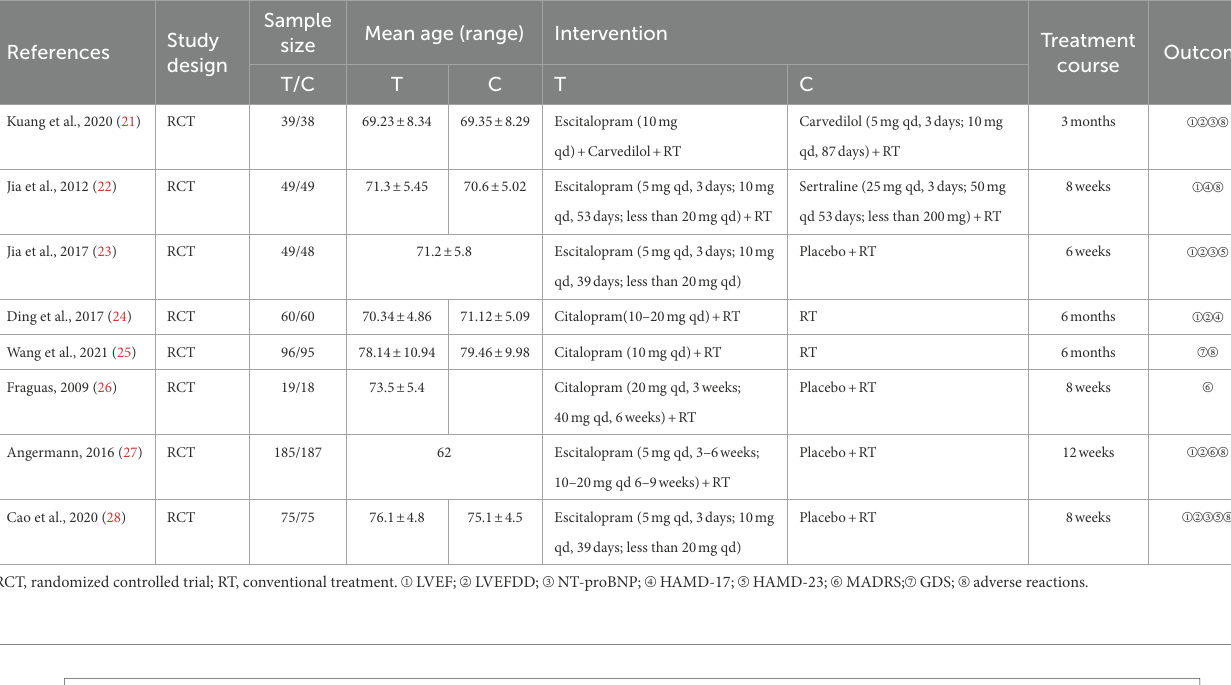
TABLE 1 Characteristics of the included studies.